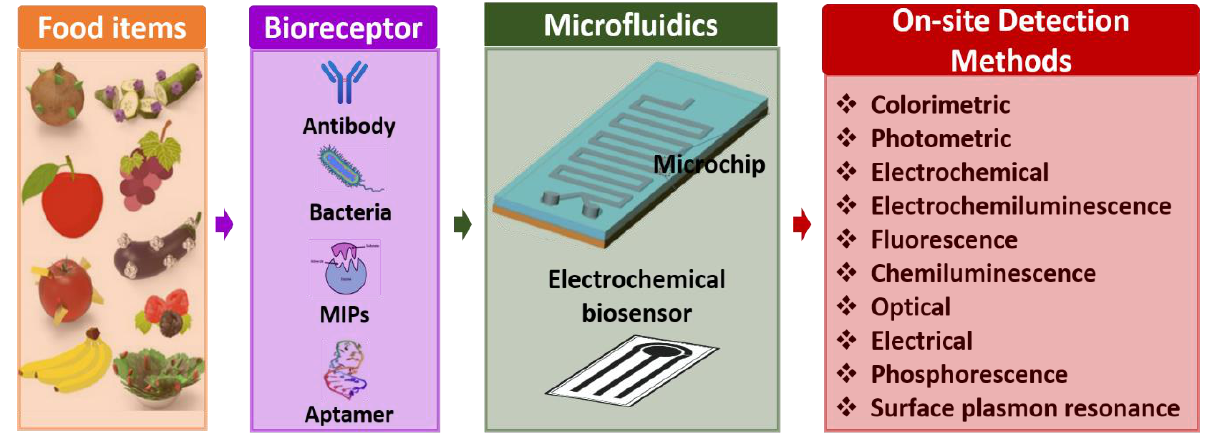
Figure 6. Overview of microfluidics-based electrochemical biosensors for detection of foodborne pathogens.